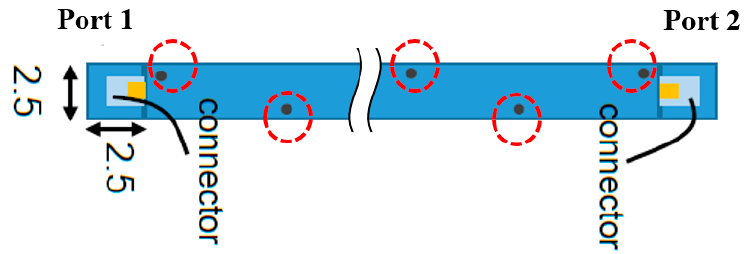
Figure 11. Simulation setup of via placement. The vias are in red dashed circles.